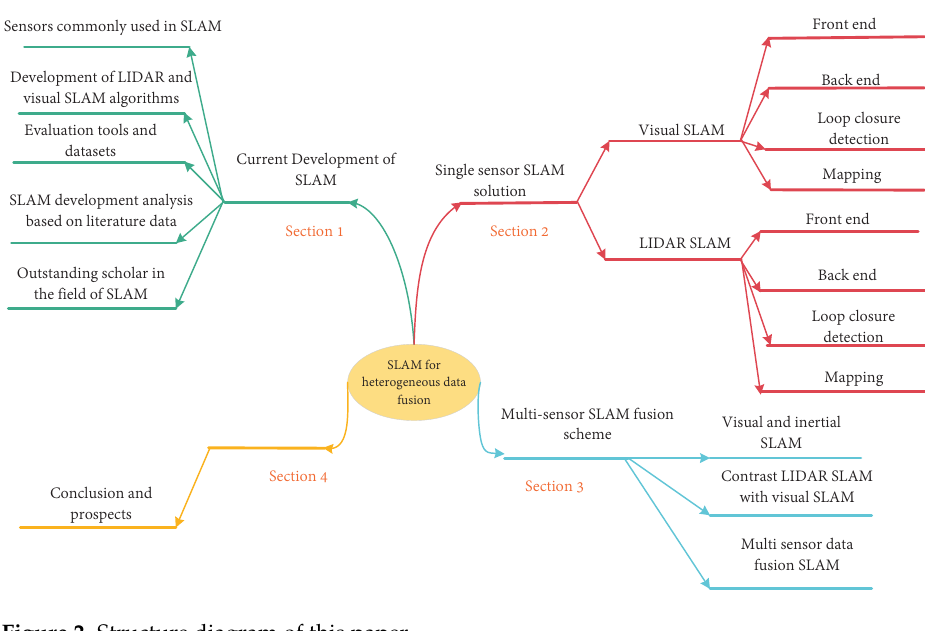
Figure 2. Structure diagram of this